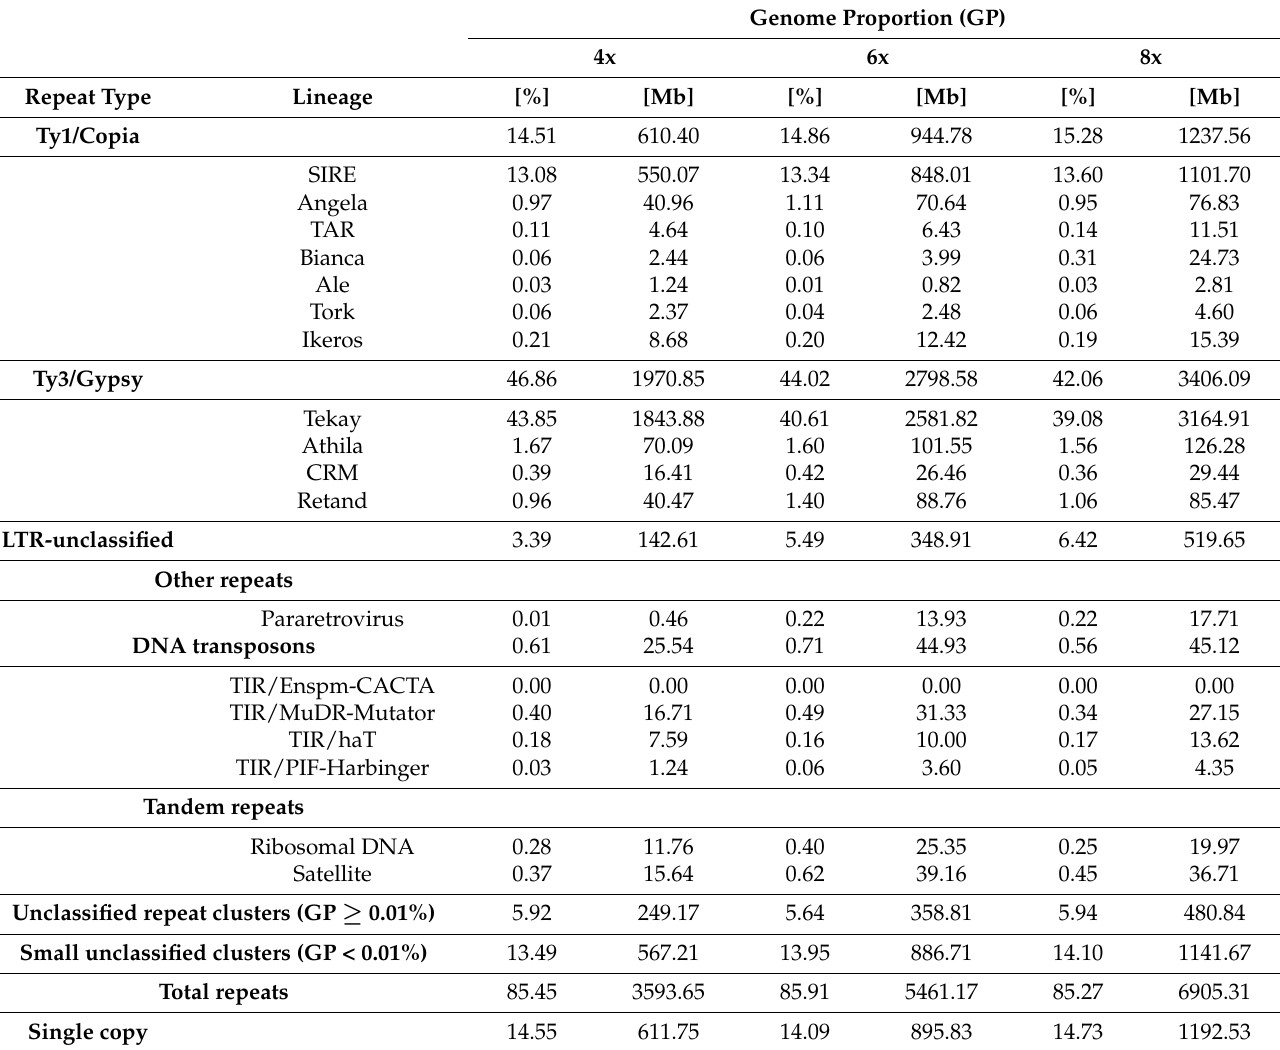
Table 1. Repetitive DNA composition estimated in individuals TG422 (4x), TG507 (6x) and TG84 (8x) as illustrative of the overall dynamics reported across